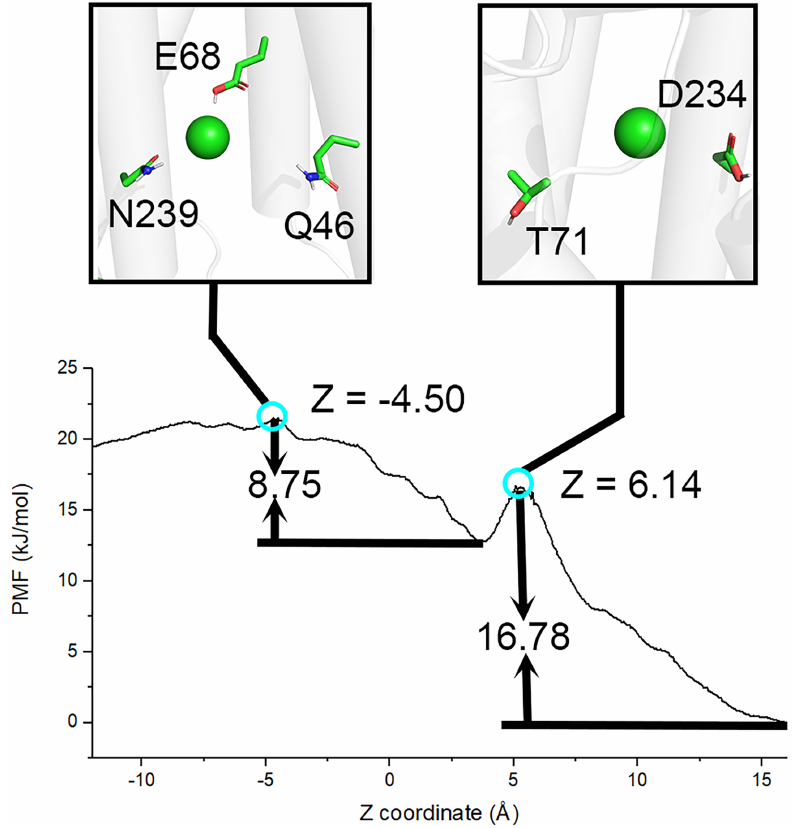
Figure 5. PMF constructed by umbrella sampling for Cl − permeation across ion channels in GtACR1- cis